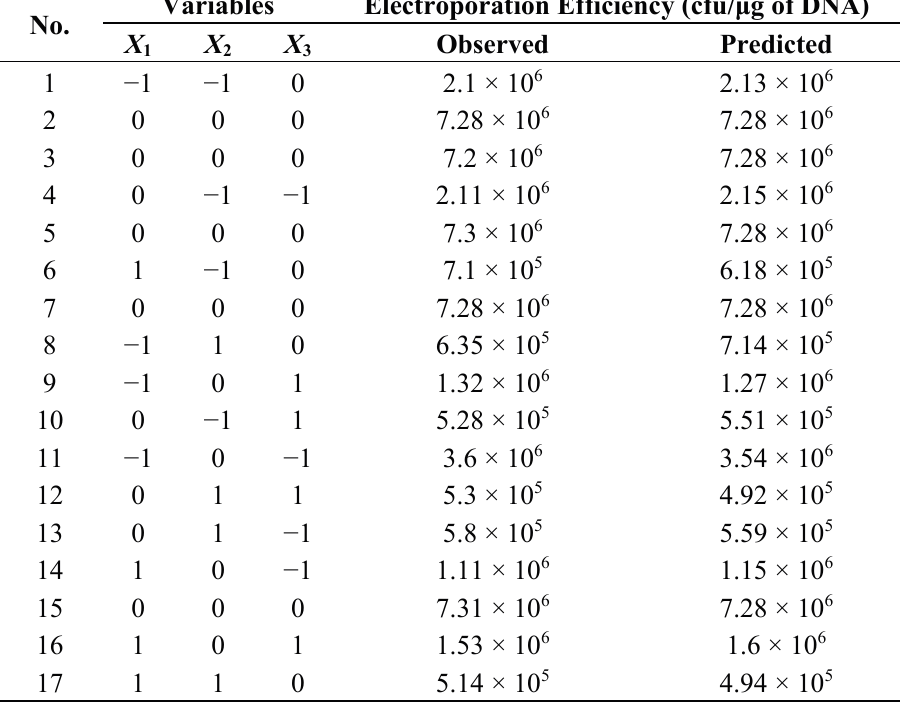
Table 2. Box-Behnken response surface (BBD) design with the predicted and observed electroporation